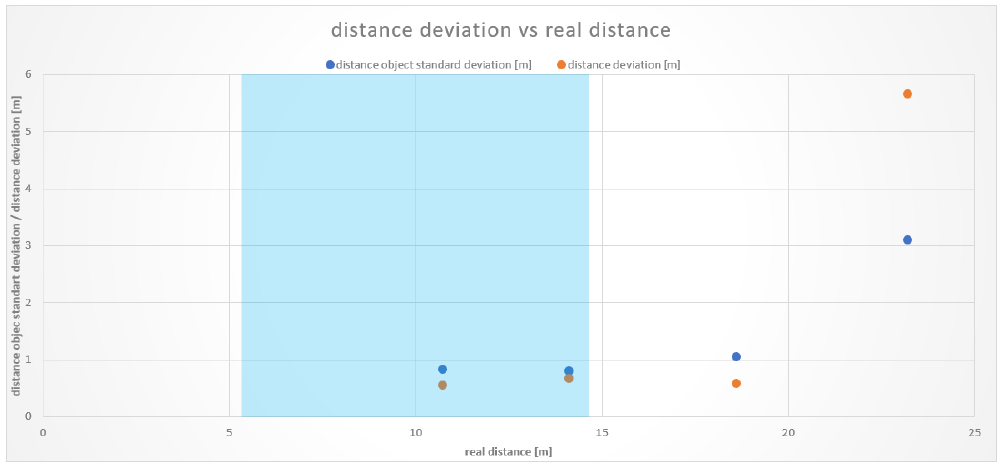
Figure 7. Working area of the Tailigator on a straight road section (blue marked area).